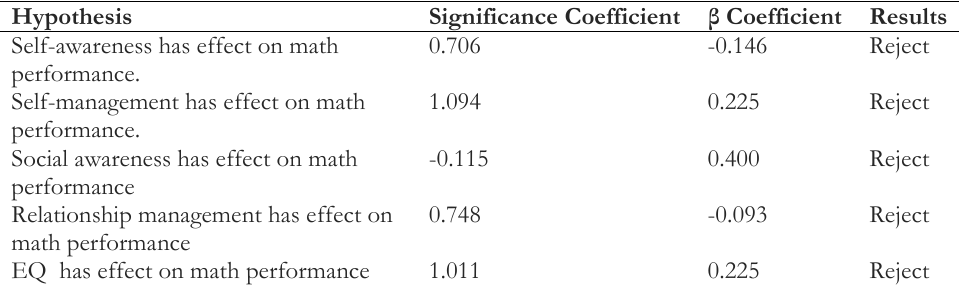
Table 7. The results of structural